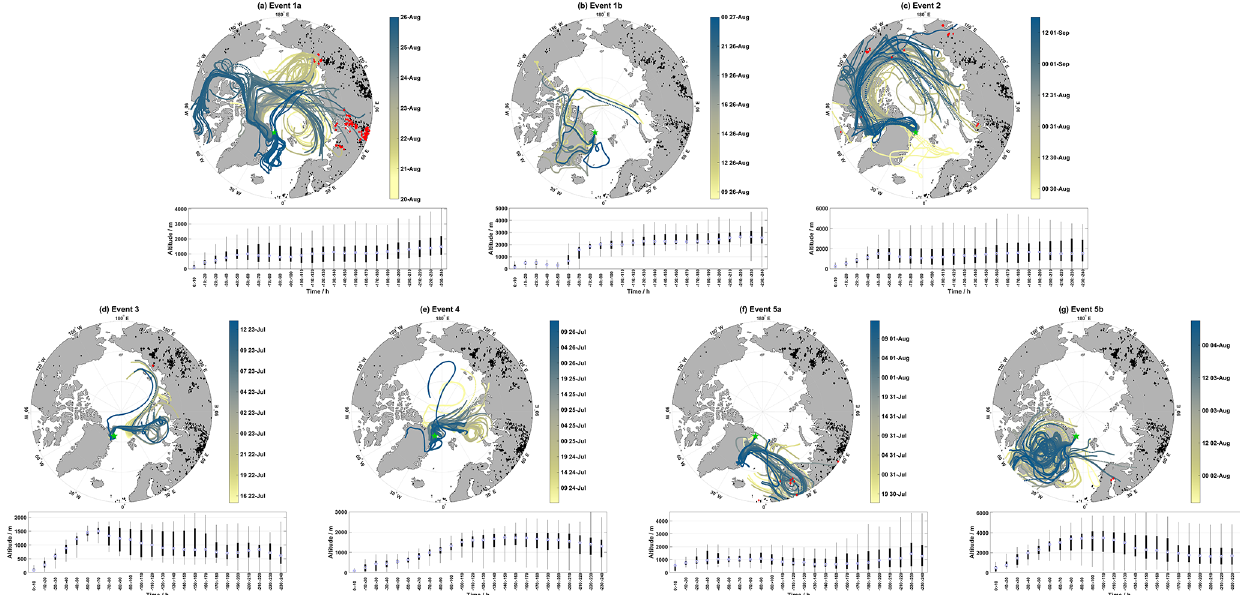
Figure 5. Map of air mass back-trajectories during Events 1–5 in (a) through (g) . Panels (a–c) show individual hourly trajectories that are colored-coded by the arrival date at Villum. as indicated by the color bar (the date format is HH dd-MMM), active fires during each event are in black, active fires intersecting trajectories within 1 ◦ latitude and longitude and within 1h are in red (active fires from the previous 10d before the start of an event were included to reflect the trajectory length). The position of Villum is marked by the green star. Panels (d–g) display boxplots of the altitude for each event binned in increments of